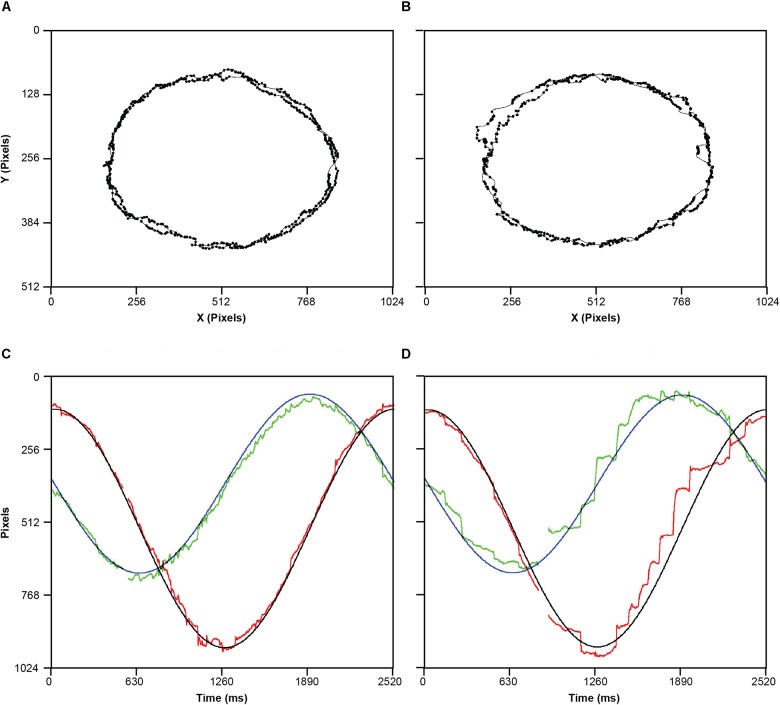
Examples of raw spatial data of eye movements for one control participant (A) and one hearing-impaired participant (B). (C) a time series representation one cycle of the target elliptical movement in X (Black) and Y (blue) position on the screen, and corresponding tracking eye movements in the X (red) and Y (green). (D) Same as C, but for a hearing-impaired participant. Missing data reflect missing samples due to eye blink. Note that all four panels represent the experimental condition where stimulus was moving anti-clockwise at slow speed.